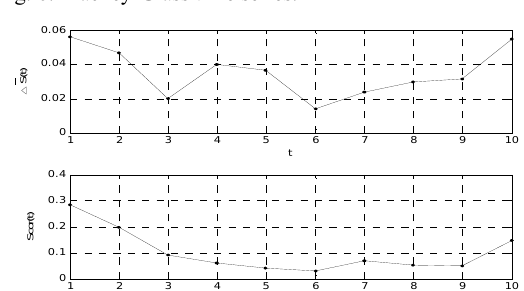
Fig. 5. Lorenz time series. Fig. 6. Mackey-Glass time series.